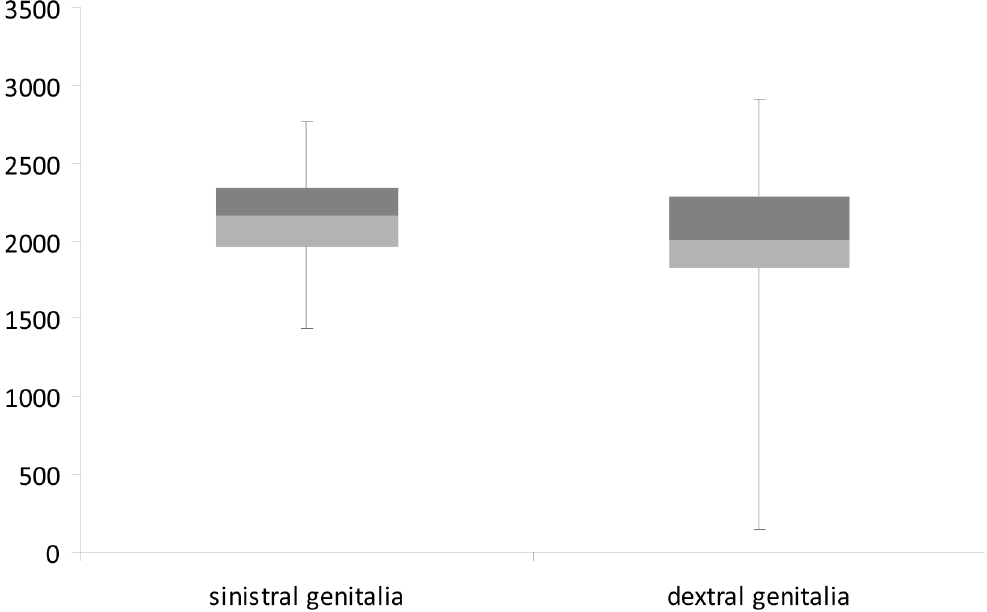
Fig 1. Copulation duration (seconds) of C . baldersoni males with sinistral and dextral genitalia when mated with virgin females. Boxplots show medians and first and third inter-quartile ranges. Whiskers are extended to maximum and minimum values. doi:10.1371/journal.pone.0128755.g001 supra-anal plates are observable as are most of the male VLC and RP (Fig 4). The position of the jagged PDA can be inferred from the distention of the female abdomen (Fig 4). The posi- tions of male structures upon the bilaterally symmetrical female genitalia are identical but mir- ror-imaged between sinistral and dextral males.